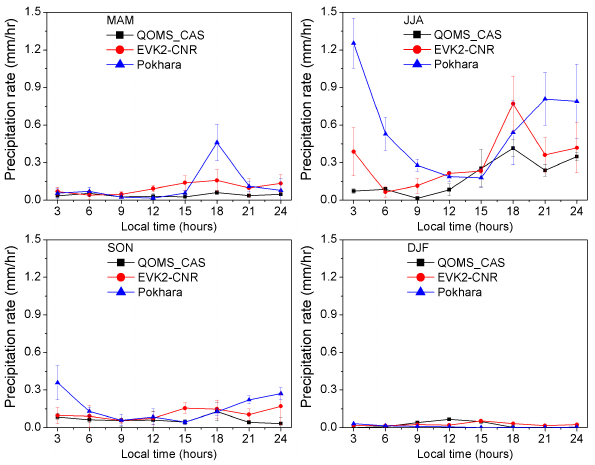
Fig. 9. Percentage deviations of hourly average AOD at 500nm rel- ative to their daily mean across all seasons at QOMS_CAS, EVK2- CNR and Pokhara. The error bars indicate the inter-annual differ- ence of relative AOD at each hour. The black scale on the left is for QOMS_CAS and Pokhara, while the red scale on the right is for